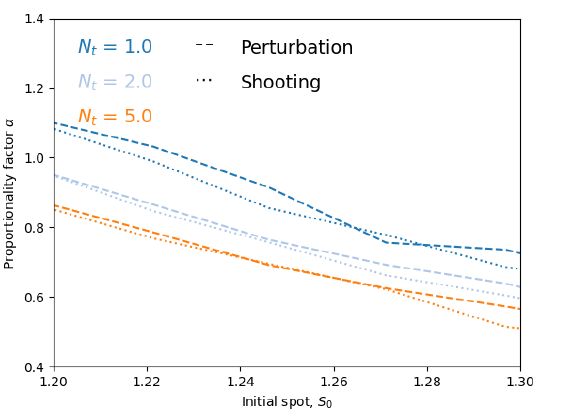
Figure 2. The proportionality factor, α , as a function of the initial spot, S 0 , calculated using the perturbation and shooting methods for a dividend rate of δ = 0.5 and for various numbers of updates of the intrinsic value, N t